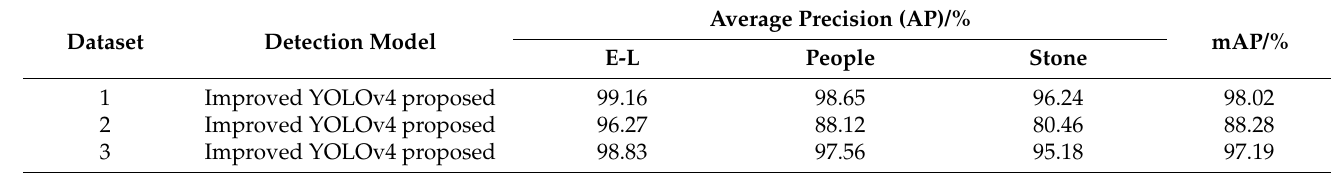
Table 3. Experimental results based on three